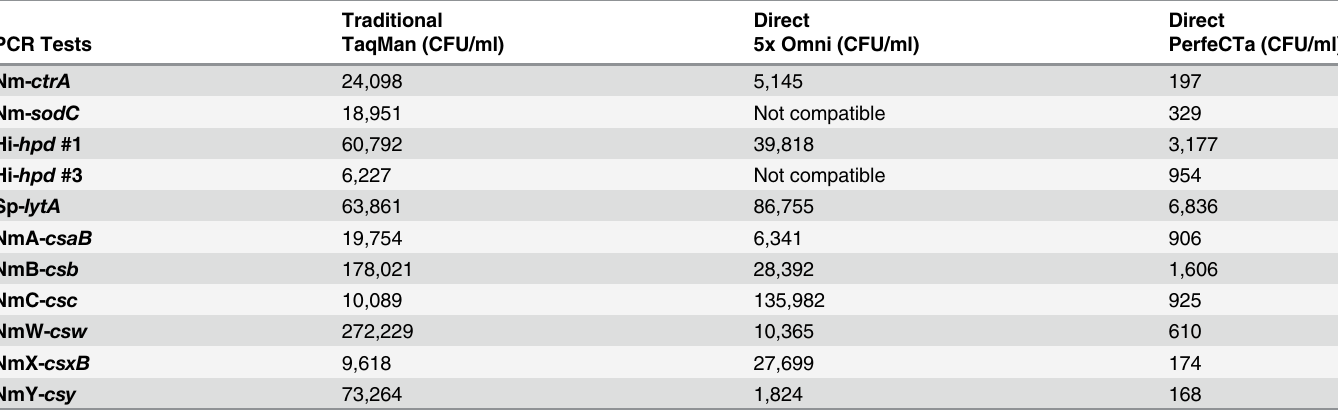
Table 2. Lower limits of detection for the real-time PCR tests using traditional and direct methods.